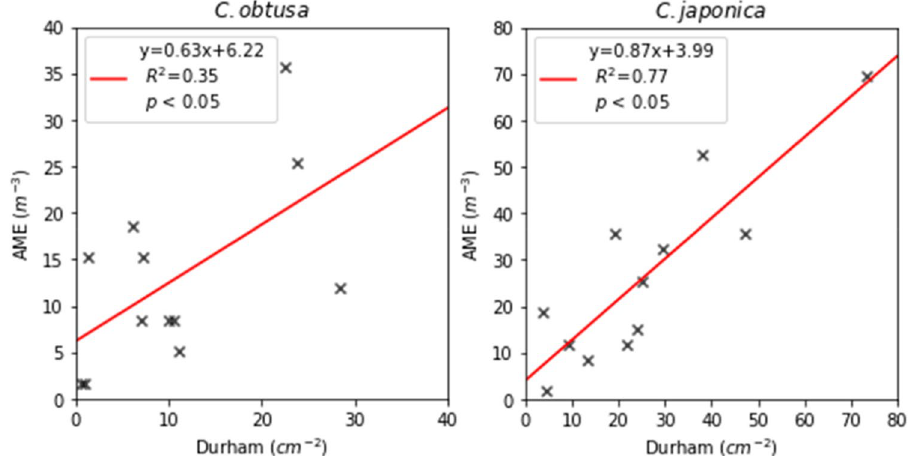
Figure 8. Relationship between estimation results of Chamaecyparis obtusa (left) and Cryptomeria japonica (right) by the Automated Multi-taxa Pollen Counting Estimation System (AME) system and Durham